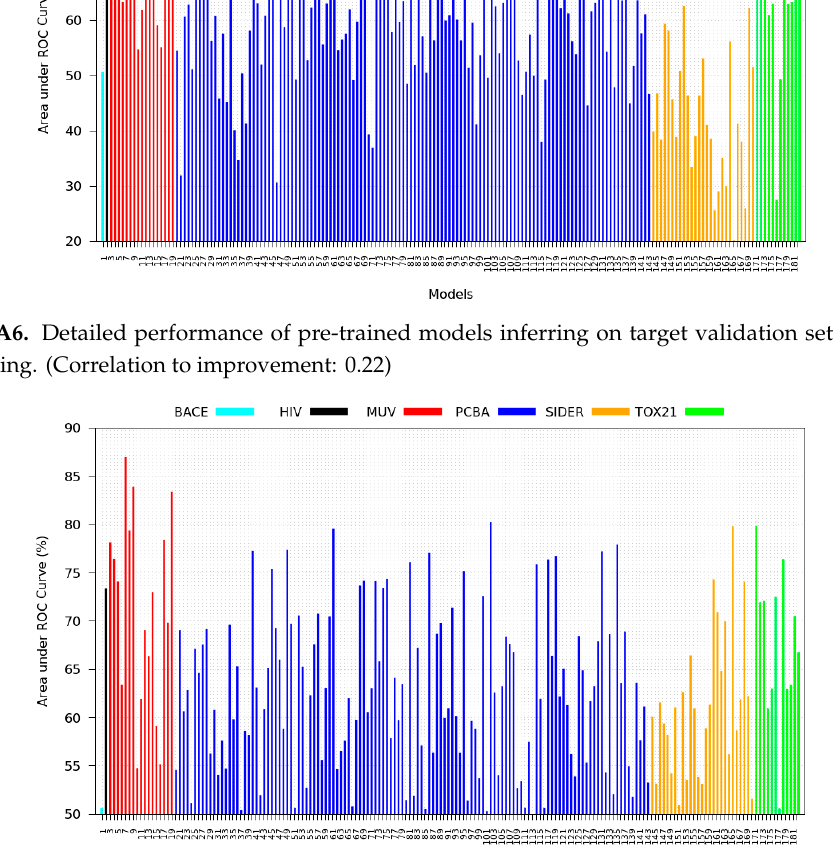
Figure A7. Detailed performance of pre-trained models inferring on target validation set without fine-tuning, results smaller than 0.5 are flipped to be larger than 0.5. (Correlation to improvement: 0.08). Table A1. Details of the common architecture and hyper-parameters.